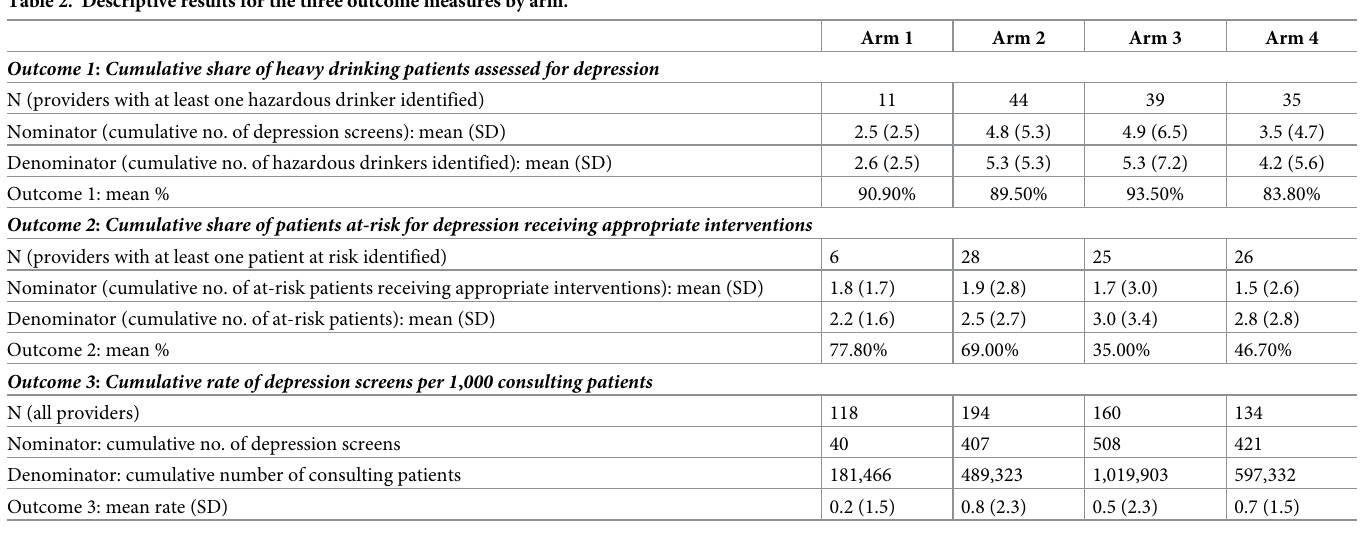
Table 2. Descriptive results for the three outcome measures by arm.